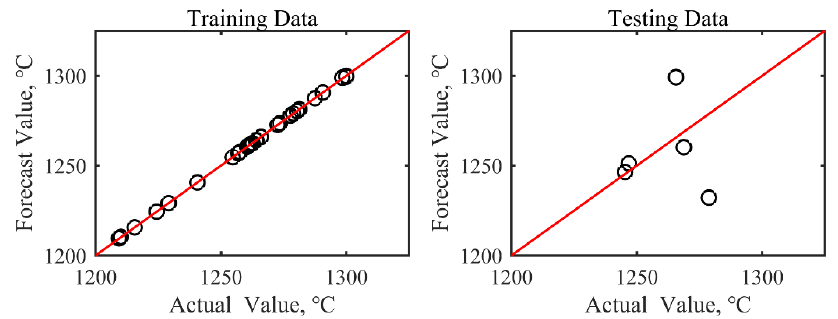
Figure 8. Actual value and forecast value of T sp 3.